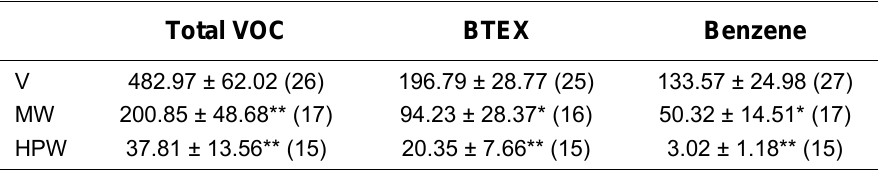
Results Obtained for the Environmental VOC Determination (µg/m 3 ; mean ± SE) in Each Exposure